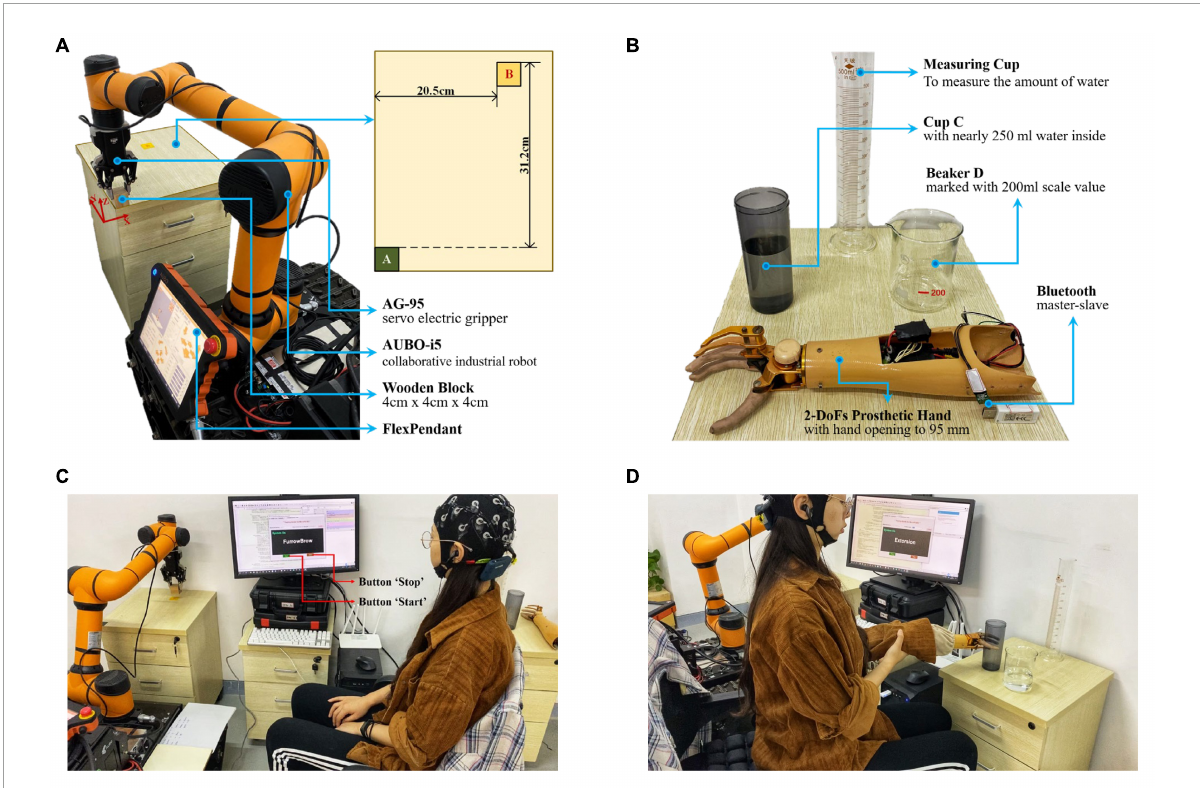
FIGURE4 The illustration for online experiment. (A) The initial state of the assembled robotic arm system in Task one (object-moving), and the plan view of the position A and B. (B) Experiment scene layout and the 2-DoFs prosthetic hand of Task two (water-pouring). (C) Experimental scene graph for Task one (object-moving). (D) Experimental scene graph for Task two (water-pouring).